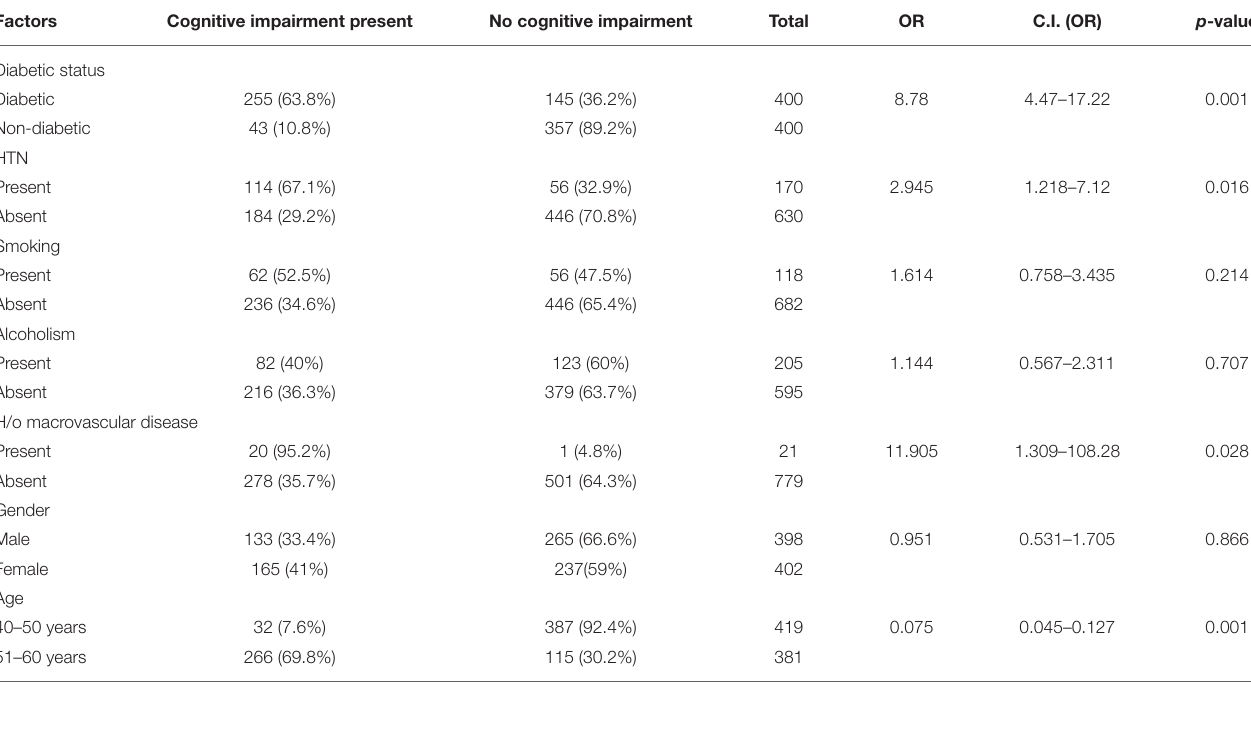
TABLE 2 | Factors associated with cognitive impairment.